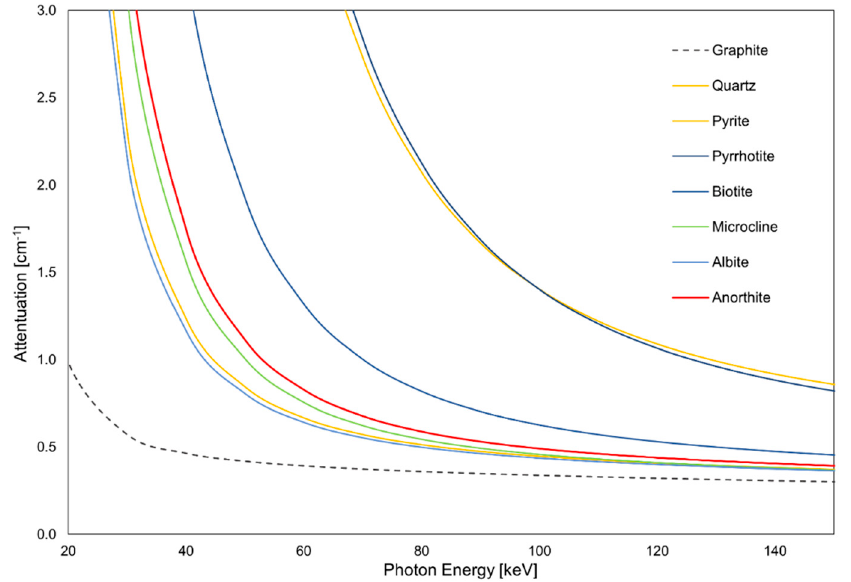
Figure 1. Linear attenuation coefficients as a function of X-ray energy for the major minerals occur- ring in the scanned sample. The values displayed in the graph calculated based on end member compositions, and densities and were calculated using the XCOM Photon Cross-Sections Database NIST [36].